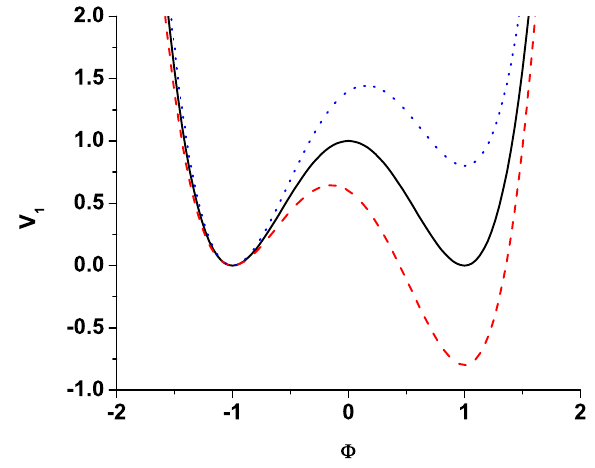
Figure 8 . The potential of a scalar field in the presence of a massive object as given in eq. (4.2). We set Λ = B = 1 . The solid line, a = 0 , shows the potential with two equal minima at φ = ± 1 . The doted line, a = − 0 . 2 , shows the potential with a false vacuum at φ = 1 and a true vacuum at φ = − 1 . The dashed line, a = 0 . 2 , shows a potential with a false vacuum at φ = − 1 and a true vacuum at φ = 1